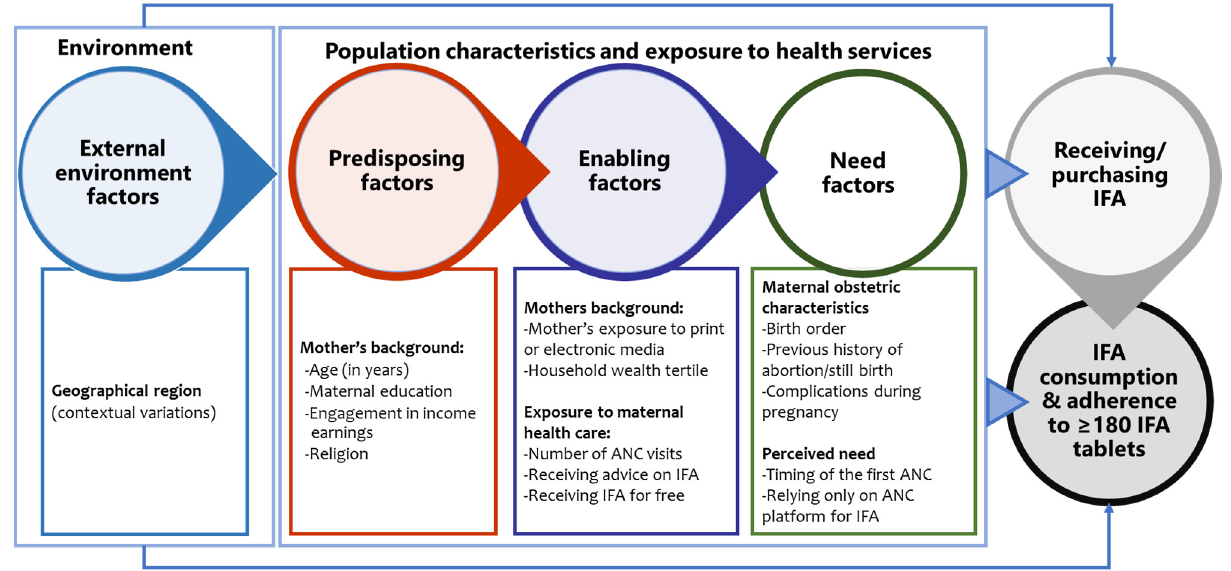
Figure 2. Conceptual diagram of factors influencing receiving and consumption of IFA based on Andersen’s Behavioral Model of health care utilisation and Siekmans et al.’s framework for IFA supplementation [21,33]. ANC—antenatal care, IFA—iron and folic acid.